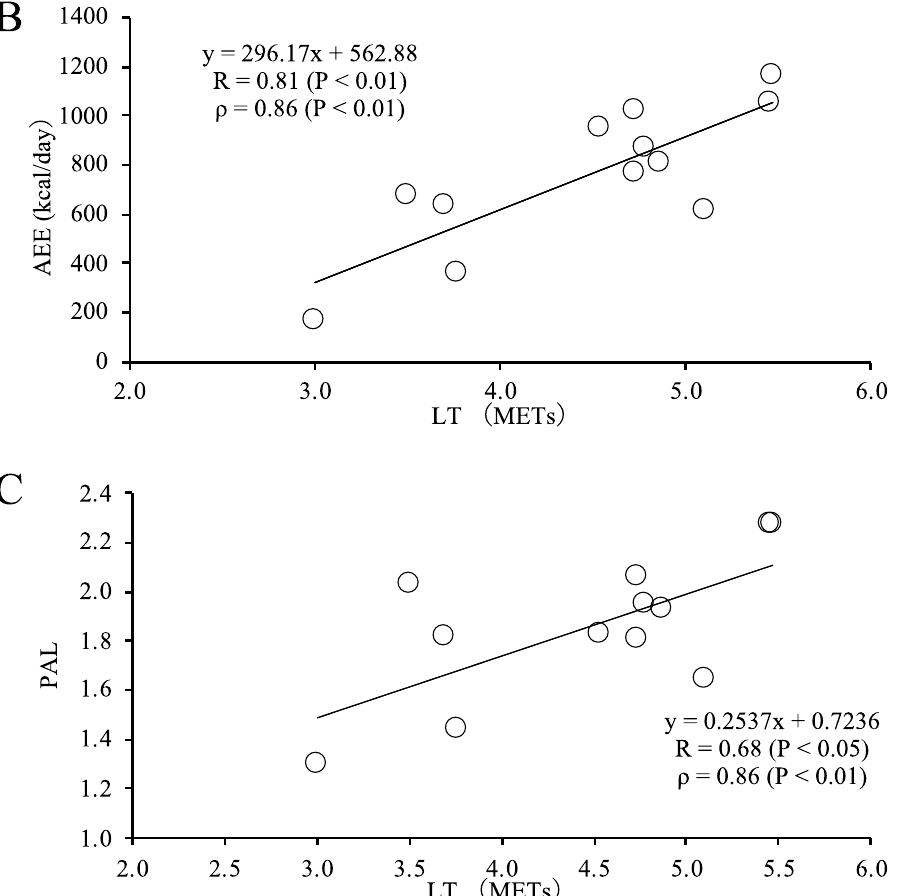
Figure 1. Relationship between LT and TEE ( A ), AEE ( B ), or PAL ( C ) r, Pearson’s correlation coefficients; ρ , Partial correlation coefficients after adjusting for sex and age.